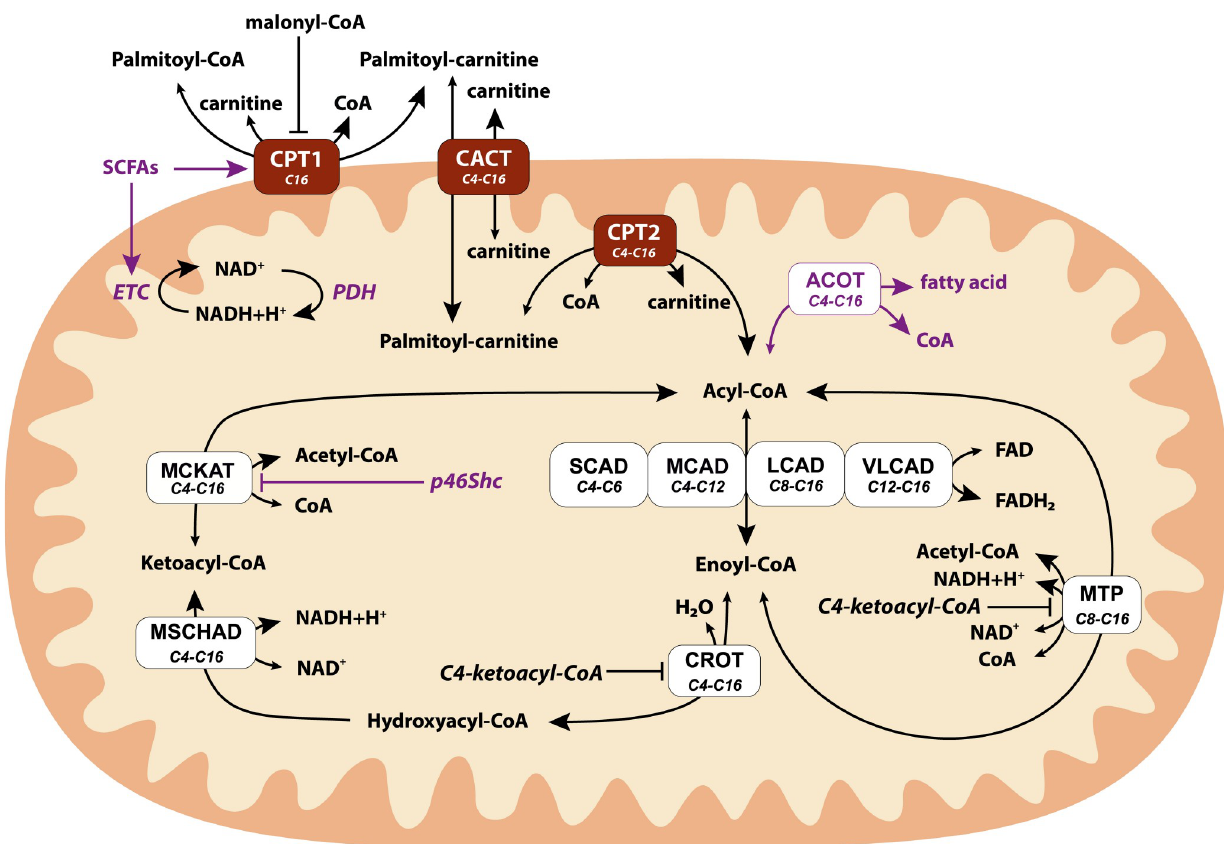
Fig 1. The mitochondrial fatty acid oxidation pathway as it modelled. Different colours denote the carnitine shuttle (dark brown), the enzymes in the β - oxidation (white) and model extensions (purple) compared to [20] which were implemented in the last part of this paper. CPT1: carnitine palmitoyltransferase 1, CACT: carnitine acylcarnitine translocase, CPT2: carnitine palmitoyltransferase 2, SCAD: short-chain acyl-CoA dehydrogenase, MCAD: medium-chain acyl-CoA dehydrogenase, LCAD: long-chain acyl-CoA dehydrogenase (not present in human mFAO), VLCAD: very-long-chain acyl-CoA dehydrogenase, CROT: crotonase, M/SCHAD: medium/short-chain hydroxyacyl-CoA dehydrogenase, MCKAT: medium-chain ketoacyl-CoA thiolase, MTP: mitochondrial trifunctional protein, ETF: electron transfer flavoprotein, ETC: electron transport chain, ACOT: acyl-CoA thioesterases, PDH: pruyvate dehydrognase, SCFAs: short-chain fatty acids. Conserved moiety : total concentration of all CoA species in the matrix. Boundary conditions: Matrix concentrations of NADH, NAD + , FADH 2 , FAD + , acetyl-CoA, free carnitine and cytosolic concentrations of free CoA, free carnitine, malonyl-CoA and palmitoyl-CoA were kept